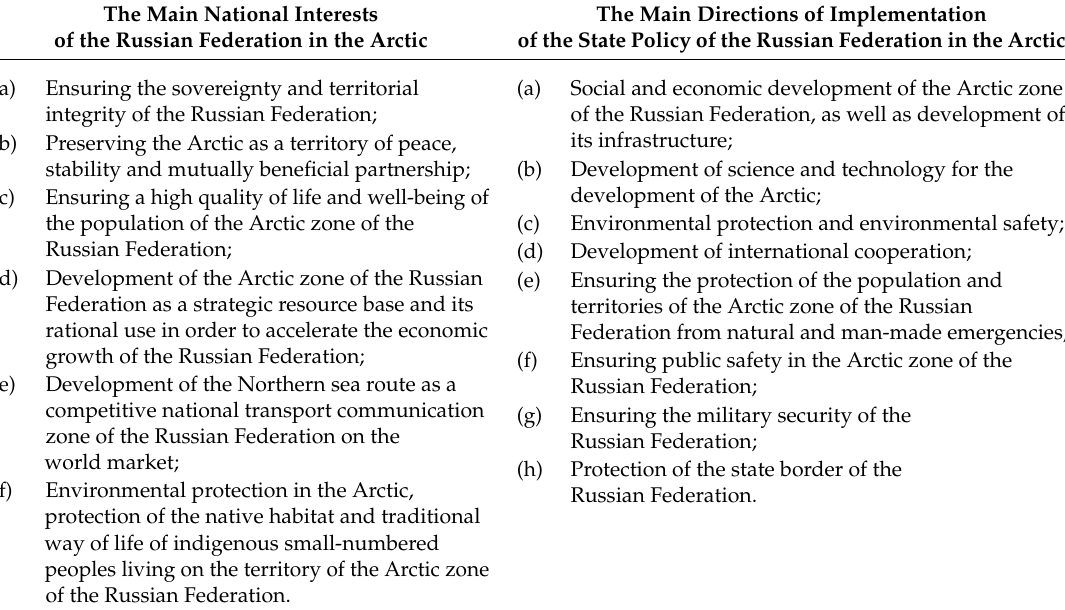
Table 1. National priorities in Russian Arctic